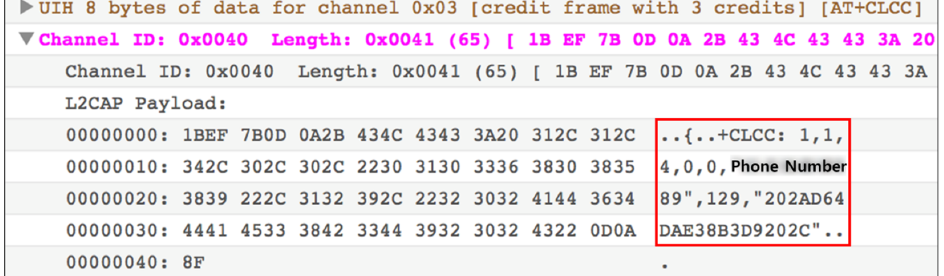
0x01 Table 5. List of Artifacts in Wireless Communication between the IVI and Mobile Device (Legacy System). IVI System